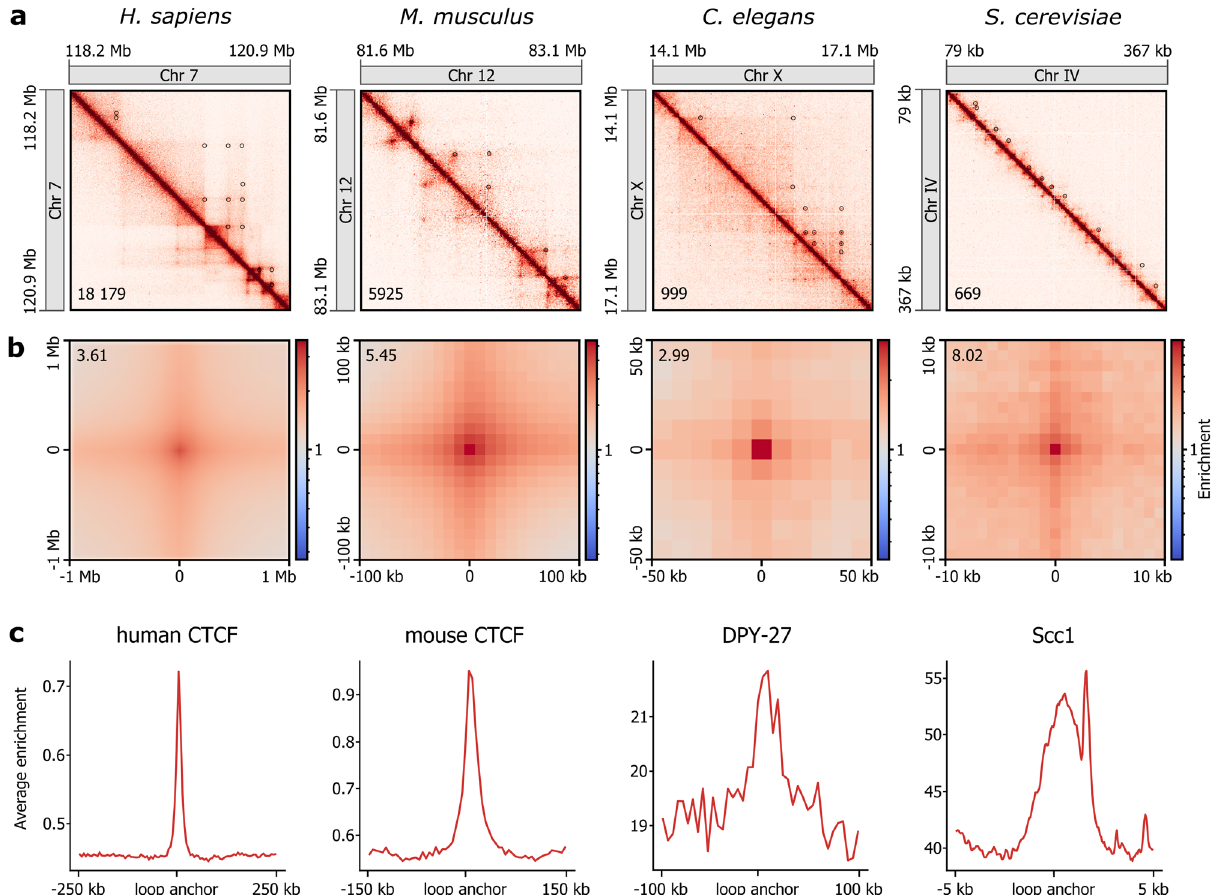
Figure 2. LASCA pipeline can be used to detect loops in different species. ( a ) Example loci for LASCA loops mapped in Hi-C datasets of H. sapiens , M. musculus , C. elegans , and S. cerevisiae . A number in the lower left corner of the heatmap shows the total number of LASCA-detected loops in each case. ( b ) Average loops identified by LASCA in H. sapiens , M. musculus , C. elegans , and S. cerevisiae Hi-C datasets. A number in the upper left corner shows the enrichment of contacts inside the loop pixel over the background. ( c ) Enrichment of ChIP-seq-obtained binding sites of the corresponding chromatin architectural proteins of H. sapiens, M. musculus, C. elegans , and S. cerevisiae around the anchors of the loops detected by